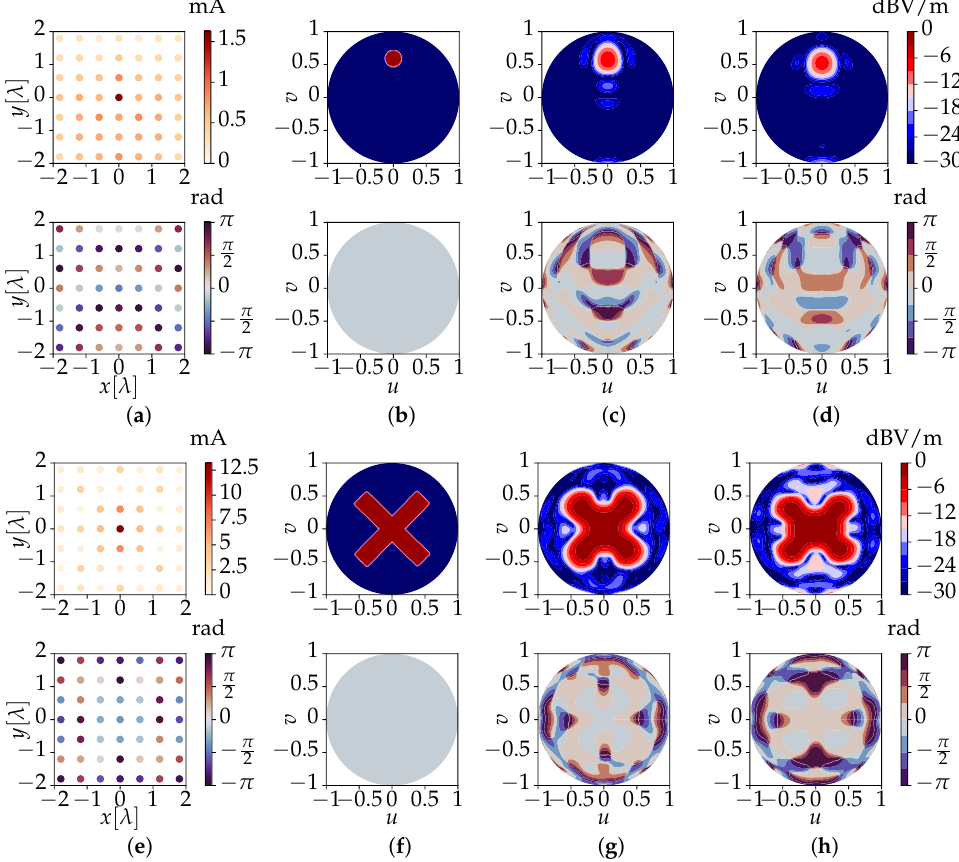
7 planar array consisting of 49 x -polarized dipoles. The figures show the Figure 7. Results for a 7 × amplitudes ( top ) and phases ( bottom ) of ( a , e ) two sets of feeding currents obtained by the novel algorithm corresponding to ( b , f ) two differently shaped target near-fields. Further, we have ( c , g ) the co-polar electric field solutions obtained by the novel method and ( d , h ) the co-polar near-fields resulting from a full-wave simulation of the 7 7 array, excited by the currents in ( a ) and ( e ), × respectively. The results are drawn for the upper hemisphere of a target sphere of radius R T = 4 λ , where u = sin θ cos φ and v = sin θ sin φ